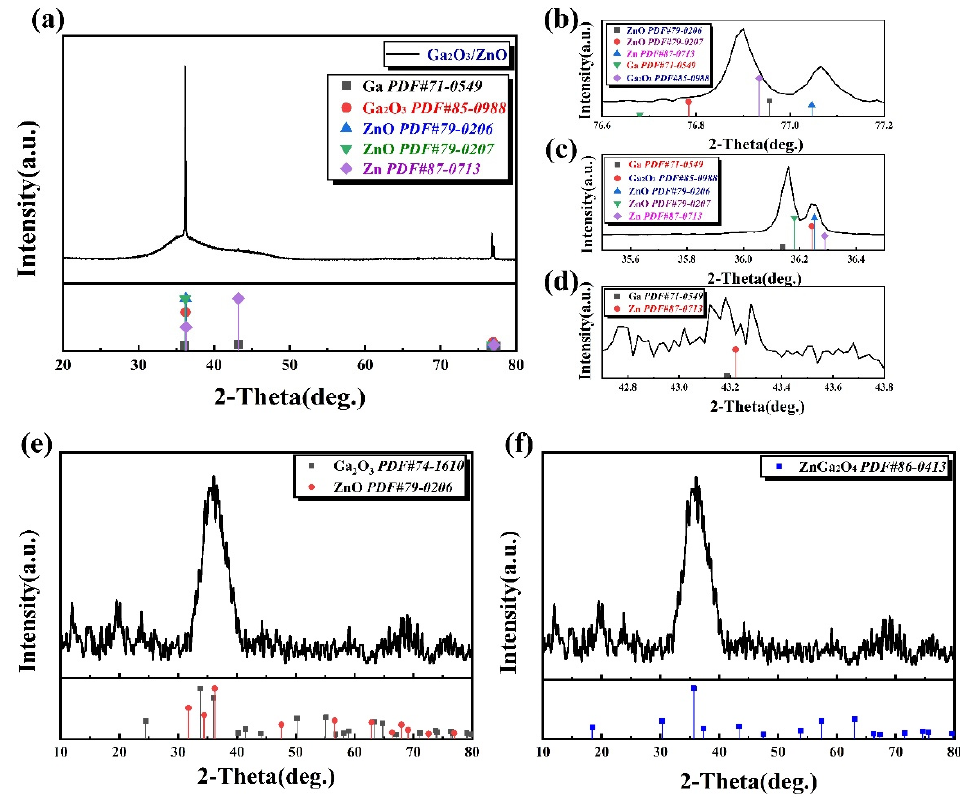
Figure 2. XRD patterns of prepared catalyst ( a ) Full XRD patterns of Ga 2 O 3 /ZnO, ( b ) XRD patterns between 76.2 and 77.6°, ( c ) XRD patterns between 35.8 and 36.5°, ( d ) XRD patterns between 42.7 and 43.8°, and ( e , f ) XRD patterns of the catalyst after use.